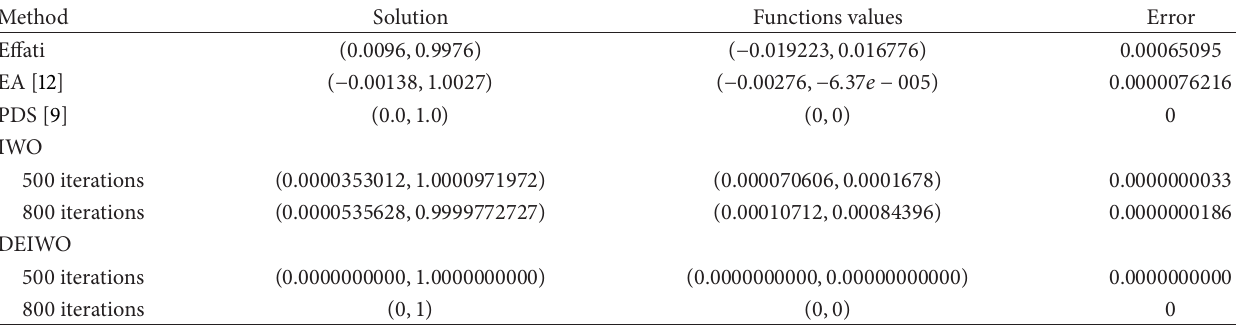
Table 5: Comparison of results for Example